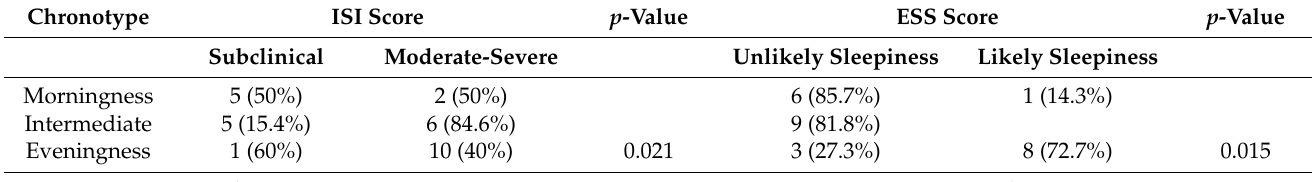
Table 3. Correlation between chronotype and insomnia severity according to insomnia severity index (ISI) and Epworth Sleepiness Score (ESS).